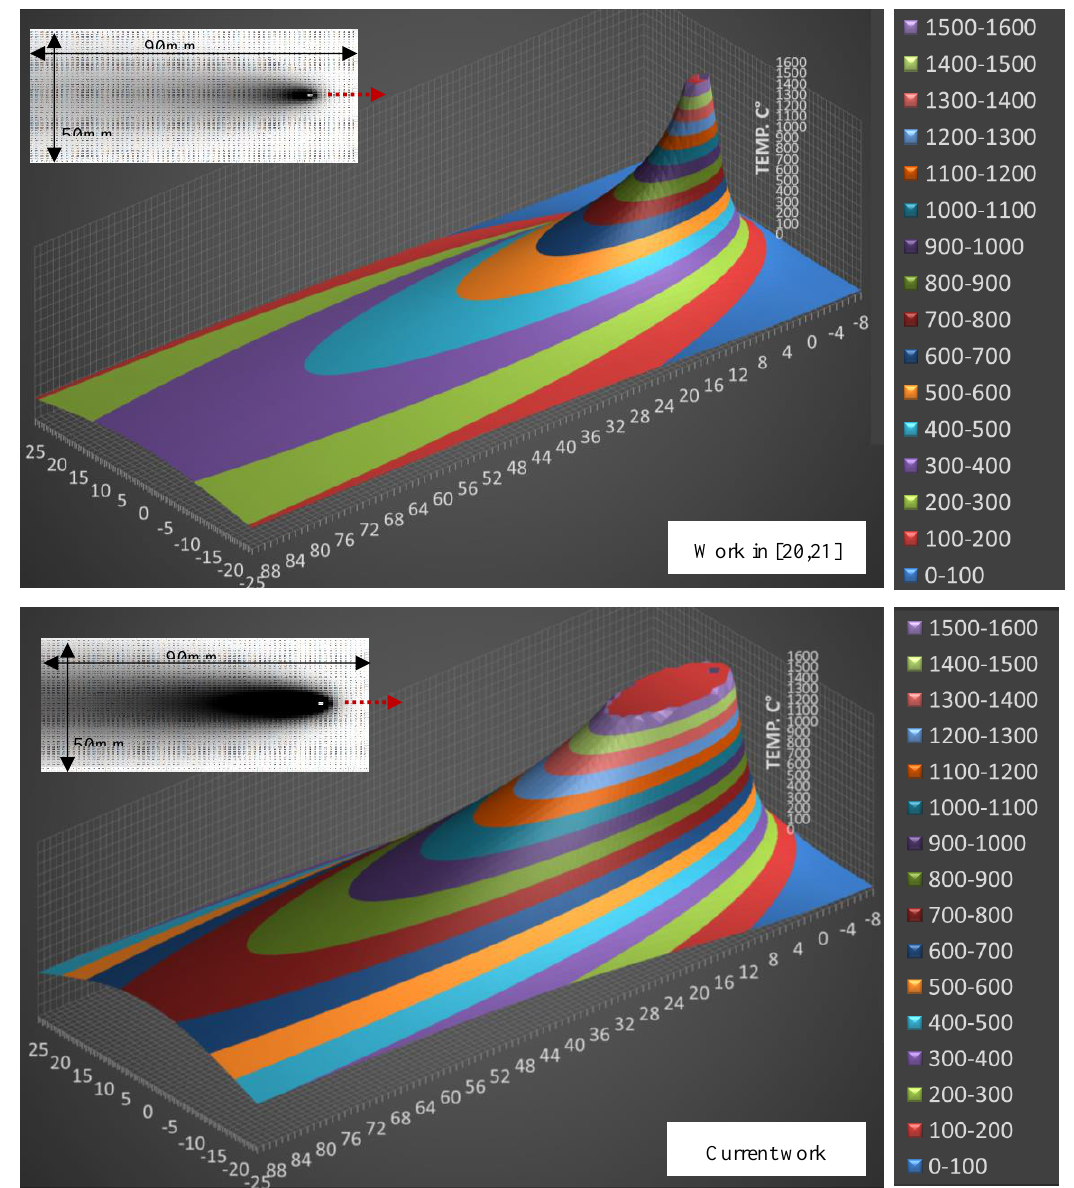
Figure 14. Surface temperature distributions ( ◦ C) around an advancing heat source as a function of (x, y) position. Solution of Rosenthal’s equation for 2D thin plates plotted at 1 mm intervals for 50 × 90 mm plate. Top: Based on Tewari and Shanker’s data [20,21] (weld parameters: 25 V, 135 A, 5 mm / s; the welding speed being assumed since no value was provided in those articles). Bottom: Current work welding parameters (33 V, 225 A, 4.9 mm / s). At the top left are 2D grayscales of temperature gradient: Black representing ≥ 1500 °C, white = 25 °C.